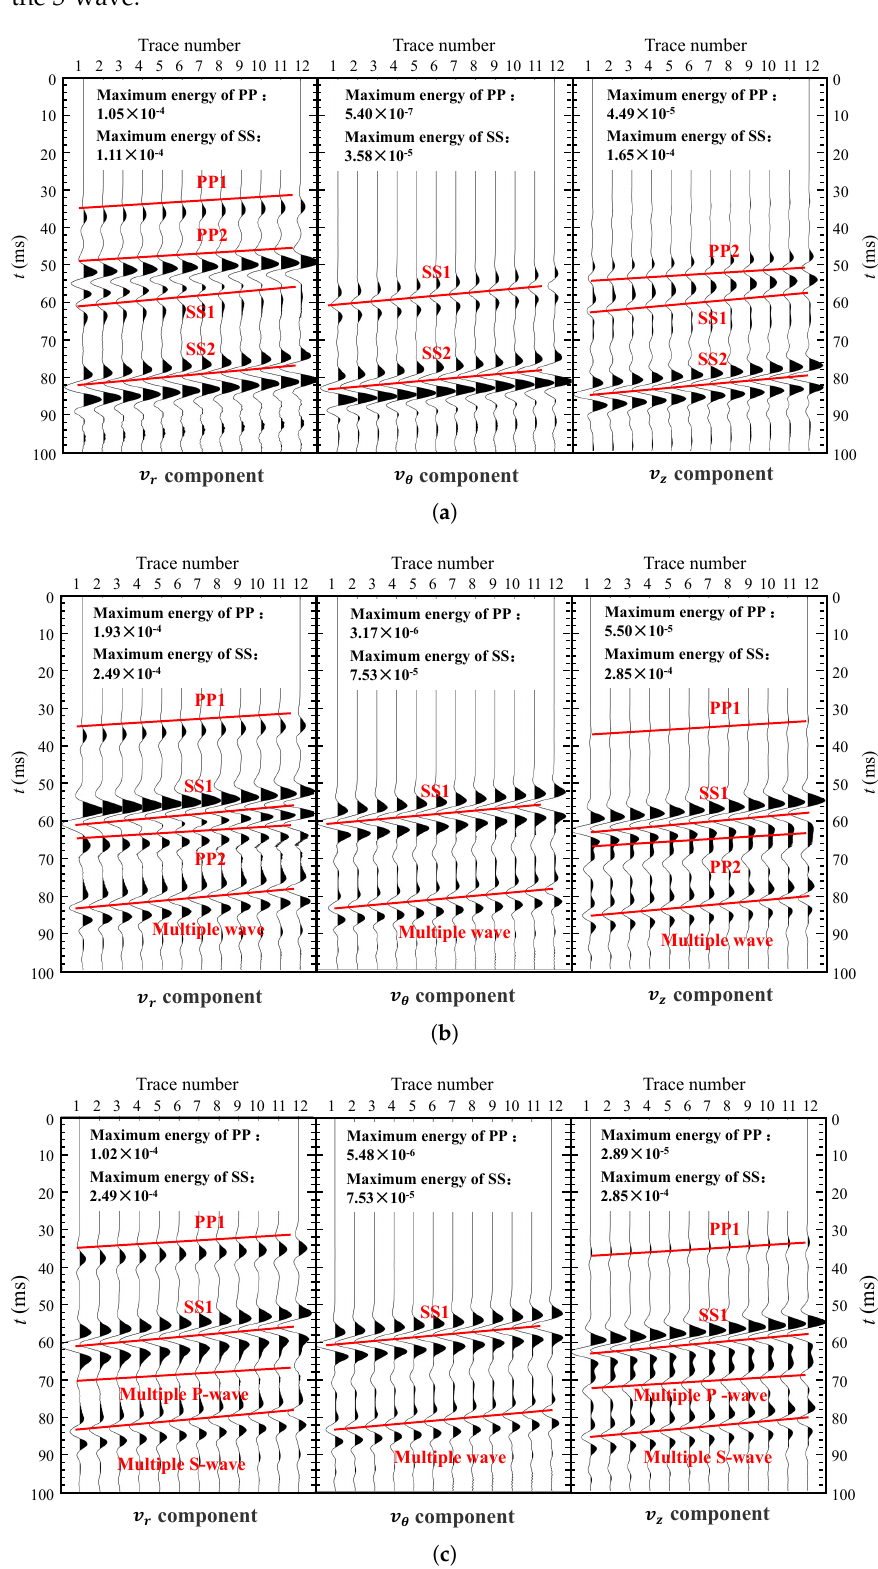
Figure 6. Three-component seismic profile of the karst cave filled with ( a ) soft soil, ( b ) water and ( c )